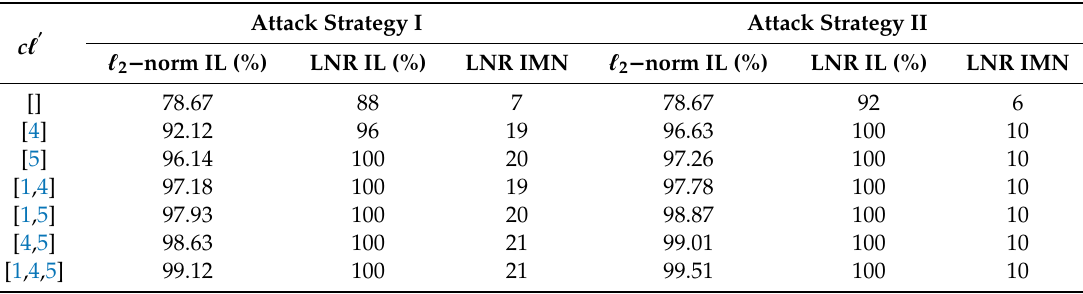
Table 5. Results of FDIA identification likelihood by using the proposed